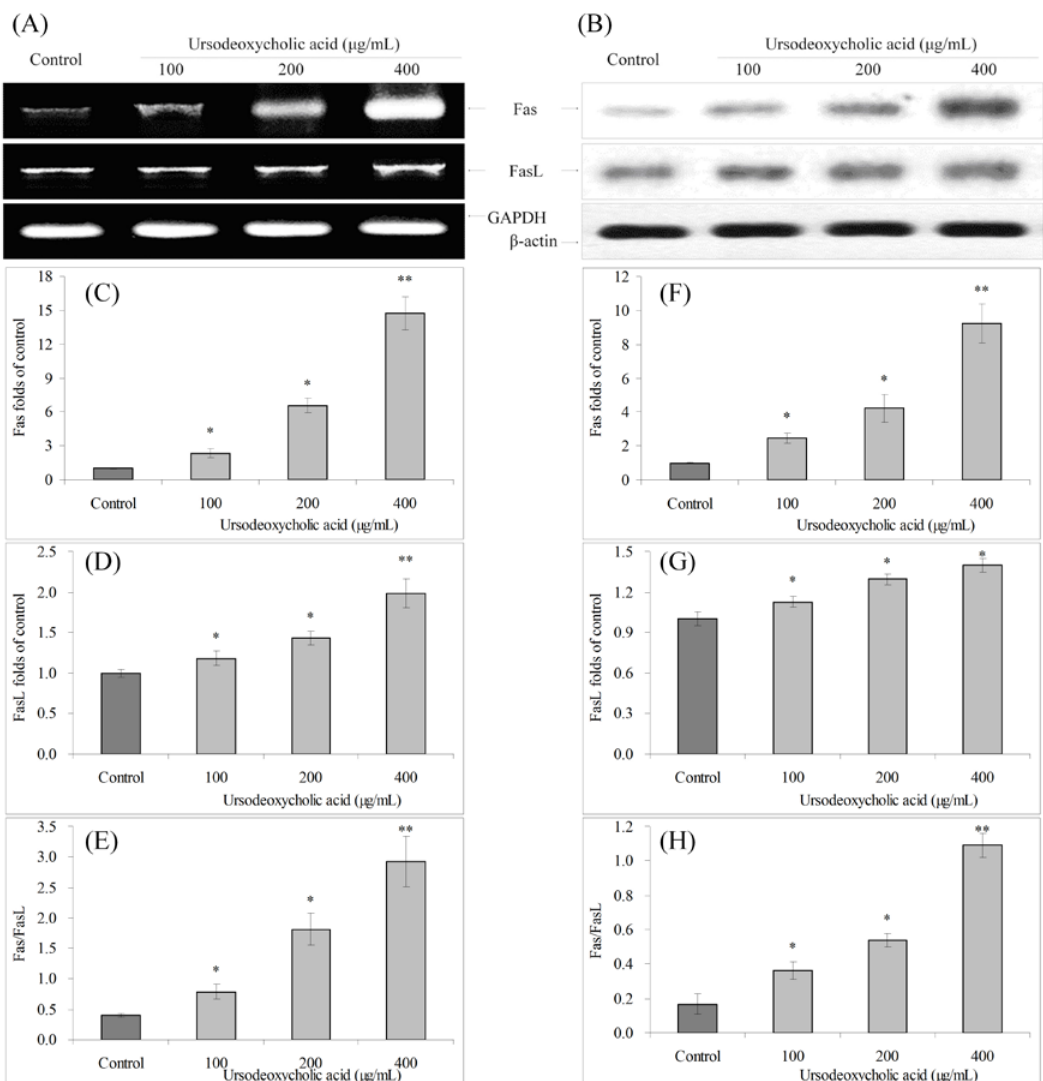
Figure 6. Effects of ursodeoxycholic acid (UDCA) on the mRNA ( A ) and protein ( B ) expression of Fas and FasL in human oral squamous carcinoma HSC-3 cells. Fold-ratio: gene expression/GAPDH (β-actin) × control numerical value (control fold ratio: 1); ( C ), Fas mRNA expression folds of control; ( D ), FasL mRNA expression folds of control; ( E ), Fas/FasL mRNA expression proportion; ( F ), Fas protein expression folds of control; ( G ), FasL protein expression folds of control; and ( H ), Fas/FasL protein expression proportion. * Mean values are significantly different from control ( p < 0.05) and ** mean values are significantly different from control ( p <